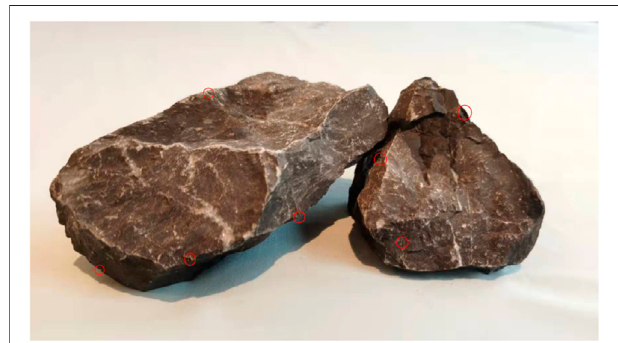
FIGURE 4 | There are many small indentations on the surface of the aquariumstones(smallred circles).IntheirMRIimage, thoseindentationsthat meet the CAF standard are used as characteristic areas, to improve the measurement